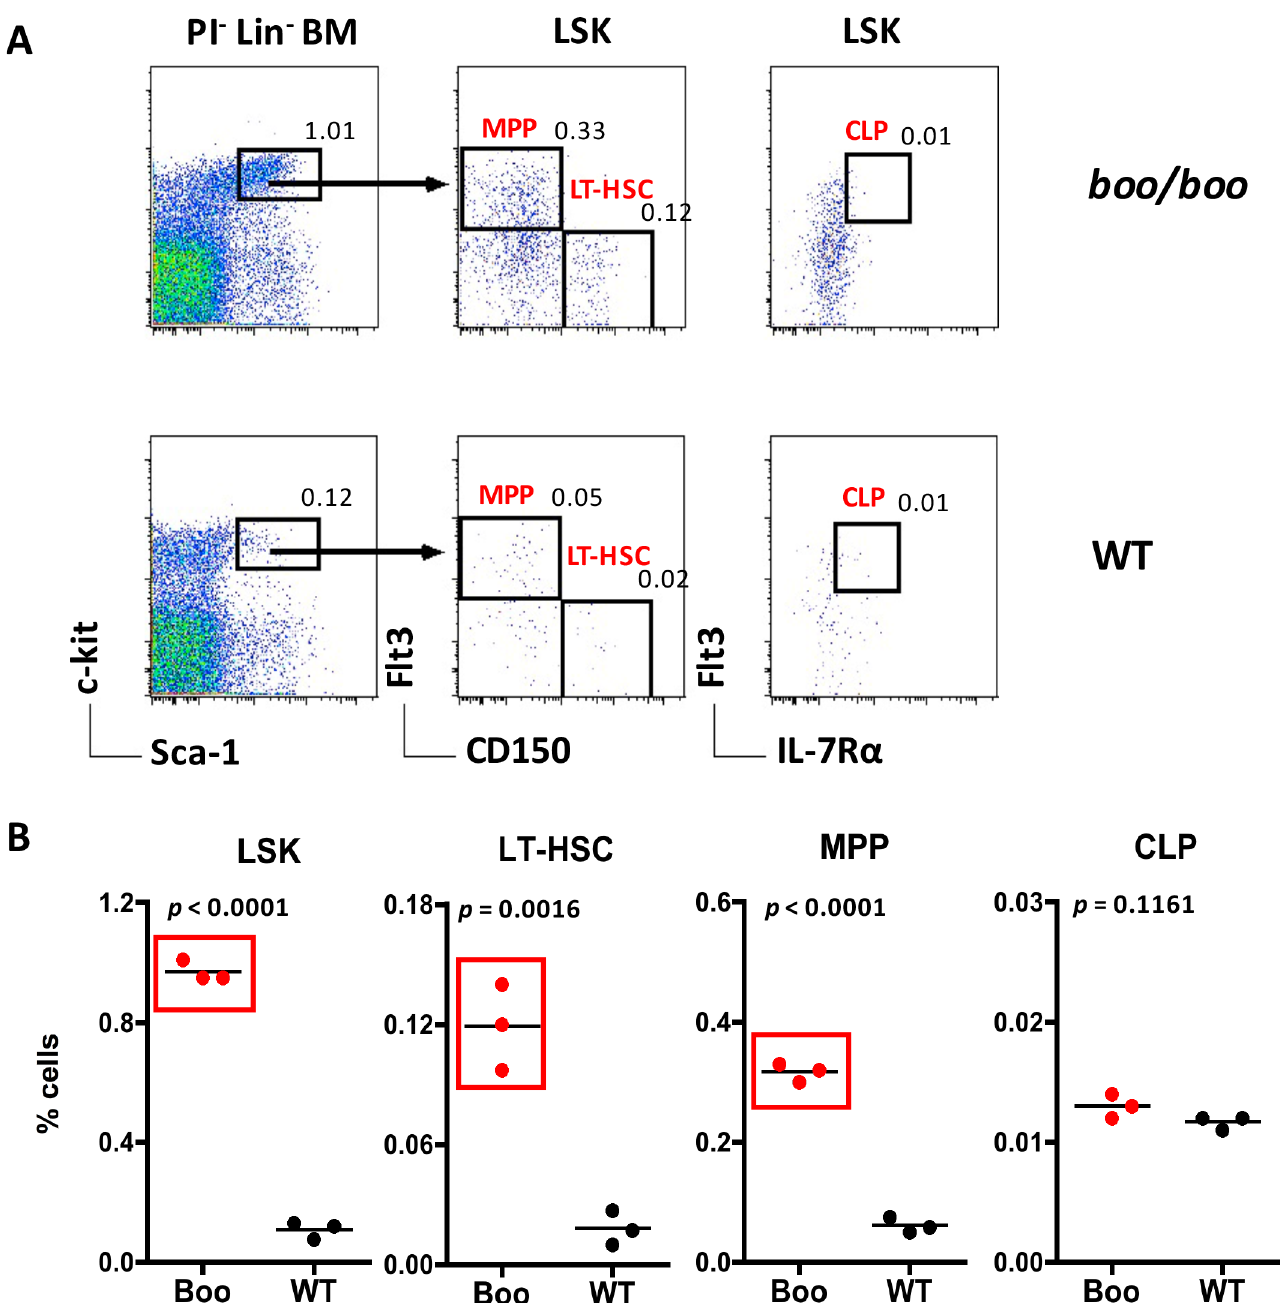
Fig 3. Analysis of bone marrow progenitors in booreana ( boo/boo ) and WT mice. Bone marrow from adult mice was preparedand stained with antibodiesto distinguishhematopoietic progenitors flow cytometrically. A lineagecocktail of antibodies was used to gate Lin - subsets, and Sca-1 and c-kit staining used to identify the Lin - c-kit + Sca-1 + (LSK) subset. Stainingfor Flt3 and CD150 was used to distinguish LT-HSCs and MPPs, and stainingfor IL-7R and Flt3 was used to distinguish CLPs. Propidiumiodide(PI; 1 μ g/ml) staining was used to gate live cells as PI - . Gates were set on bivariateplots using isotype control antibodies,and numbers in gates reflect % positive cells amongst Lin - PI - bone marrow cells. (A) Stainingprofiles for representative individualmice are shown. (B) Percent cells amongst viableLin - bone marrow is shown for 3 individual mice, with mean shown by a bar and statistically significantresults (p (cid:20) 0.05) boxed in red.